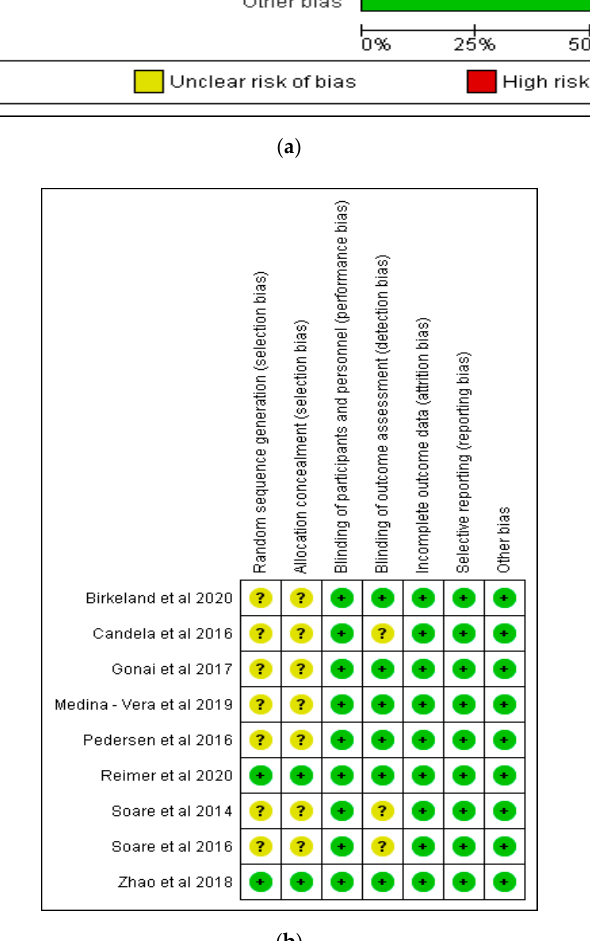
Figure 2. ( a ) Risk of bias graph for the included studies. ( b ) Risk of bias summary for the included studies.